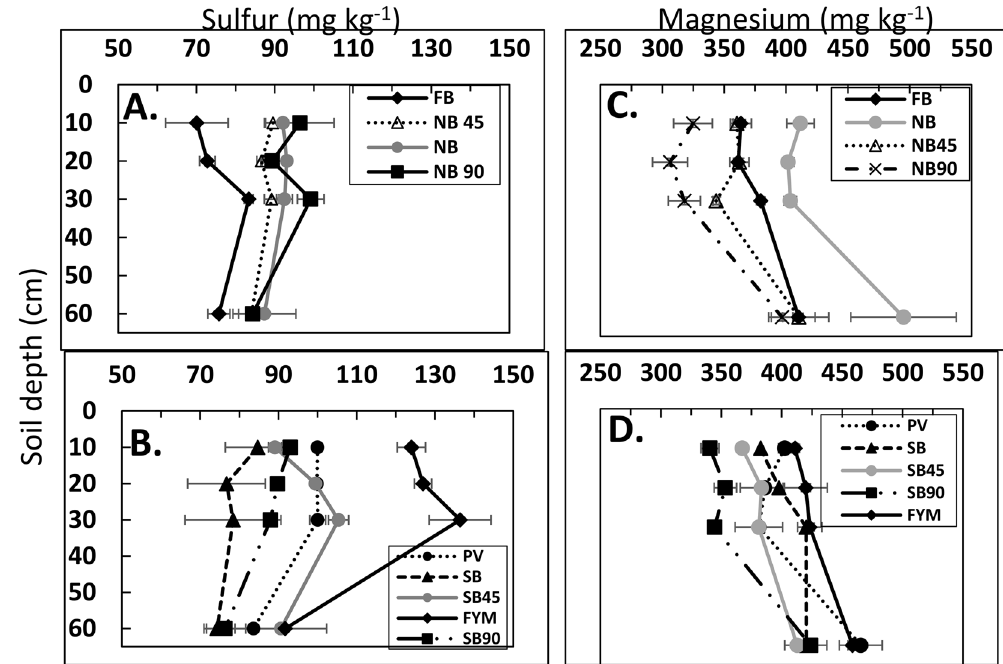
Figure 3. Soil depth function of total sulfur in 2015. ( A ) FB, NB, NB45, and NB90 plots, ( B ) PV, FYM, SB, SB45, and SB90 plots. Soil depth function of Mehlich III extractable magnesium in 2015. ( C ) FB, NB, NB45, and NB90 plots and ( D ) PV, SB, SB45, SB90, and FYM. FB = fall burn; FYM = Farmyard manure; NB, NB45 and NB90 = No burn with N applied at 0 kg ha − 1 , 45 kg ha − 1 , and 90 kg ha − 1 , respectively; PV = pea vine; SB, SB45 and SB90 = spring burn with N applied at 0 kg ha − 1 , 45 kg ha − 1 , and 90 kg ha − 1 ,